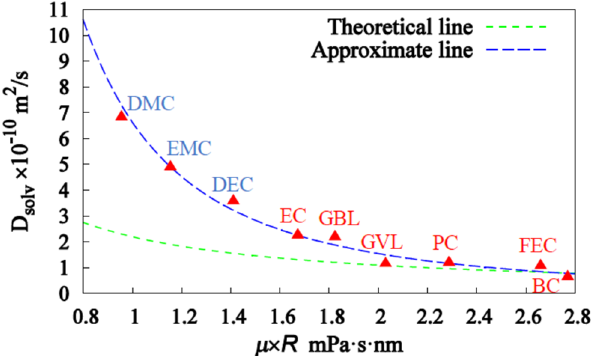
Figure 6. The curve of the Stokes–Einstein relation using the viscosity and the radius of the solvent molecule, which was calculated by MD simulations.